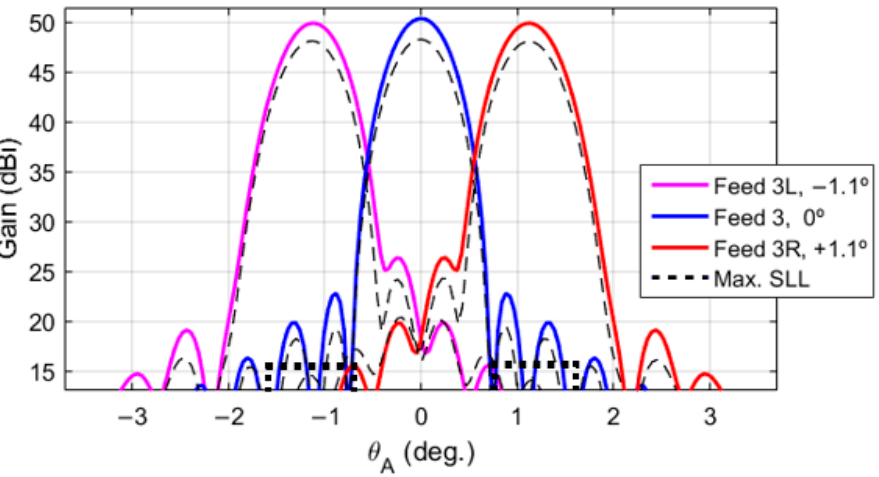
Figure 7. Simulated radiation patterns at 20 GHz in the azimuth plane of the beams generated by the bifocal DRAA (solid colored lines) and the beams produced by the equivalent monofocal DRAA (dashed lines), showing the maximum side-lobe levels (SLL, in black dotted lines) that produce the interference among beams with equal polarization.